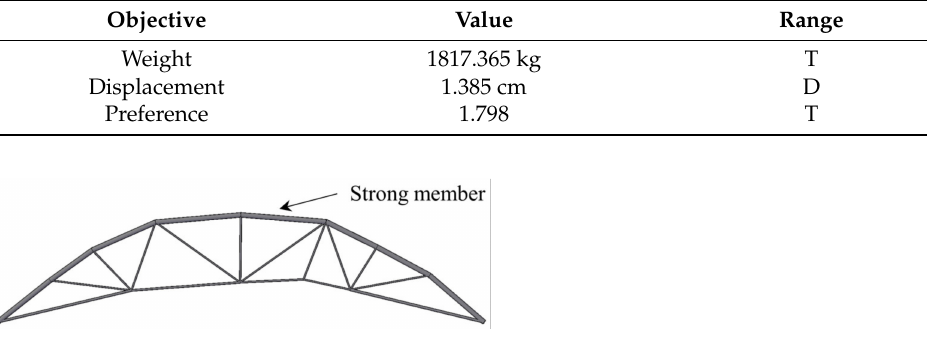
Figure 13. Truss structure for the first student.